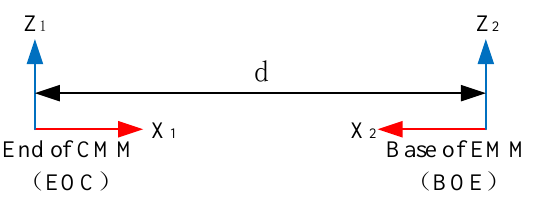
Figure 5. The coordinate definition of the mechanical